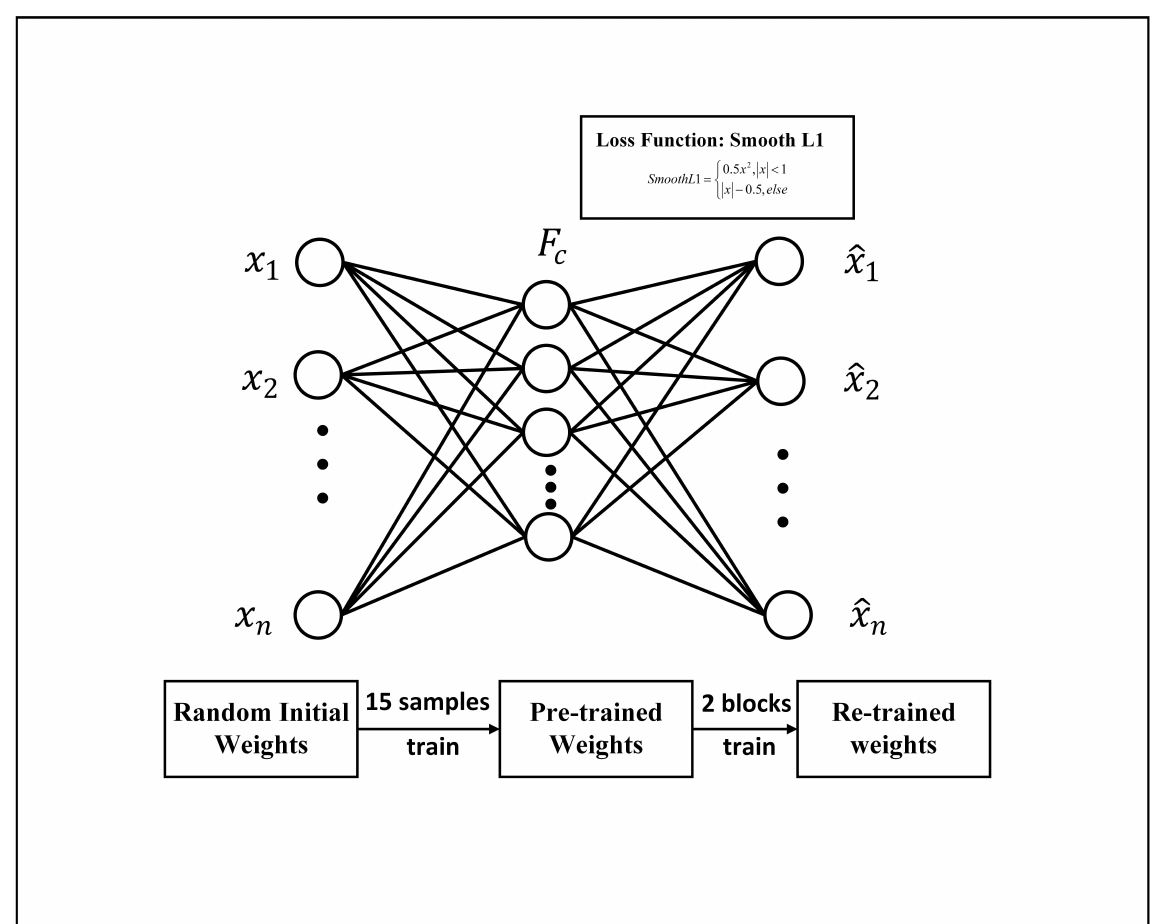
Figure 4. ANN schematic diagram.